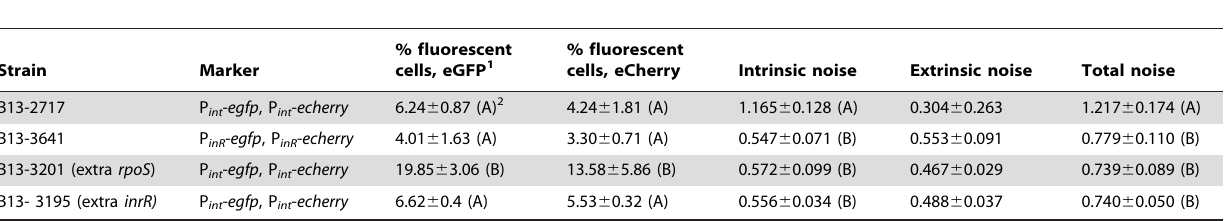
Table 4. Subpopulation proportions and noise in expression of eGFP and eCherry from dual P int or P inR fusions in cultures of P. knackmussii strain B13 or derivatives.